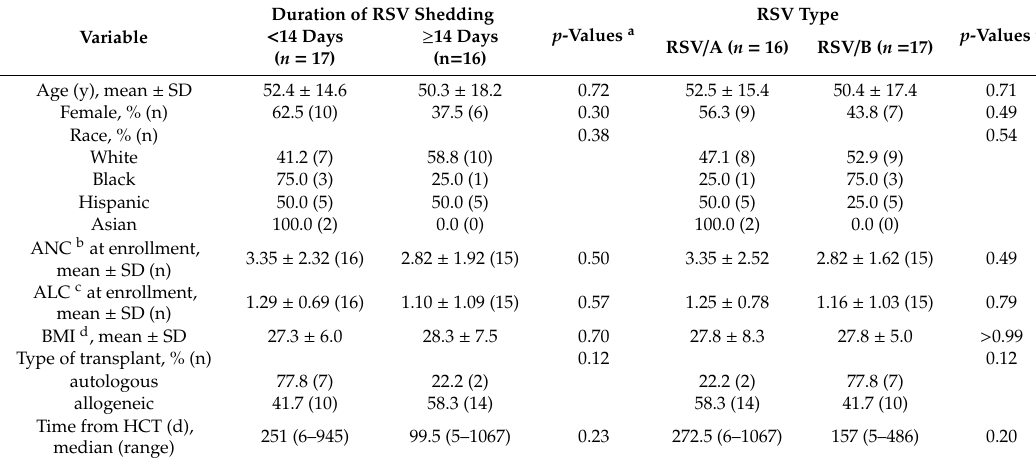
Table 1. Demographic and clinical characteristics of respiratory syncytial virus (RSV) infected hematopoietic cell transplant (HCT) recipients, stratified by duration of RSV shedding ( < 14 vs. ≥ 14 days) and by RSV type (RSV / A vs. RSV /